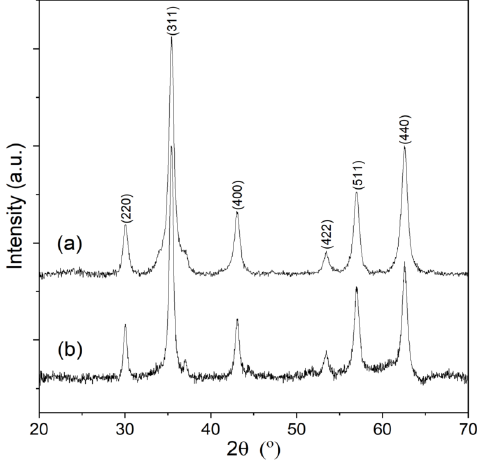
Figure 1. X-ray diffraction patterns of (a) as-received and (b) annealed at 800 °C for 1 h in the air CoFe 2 O 4 powder.